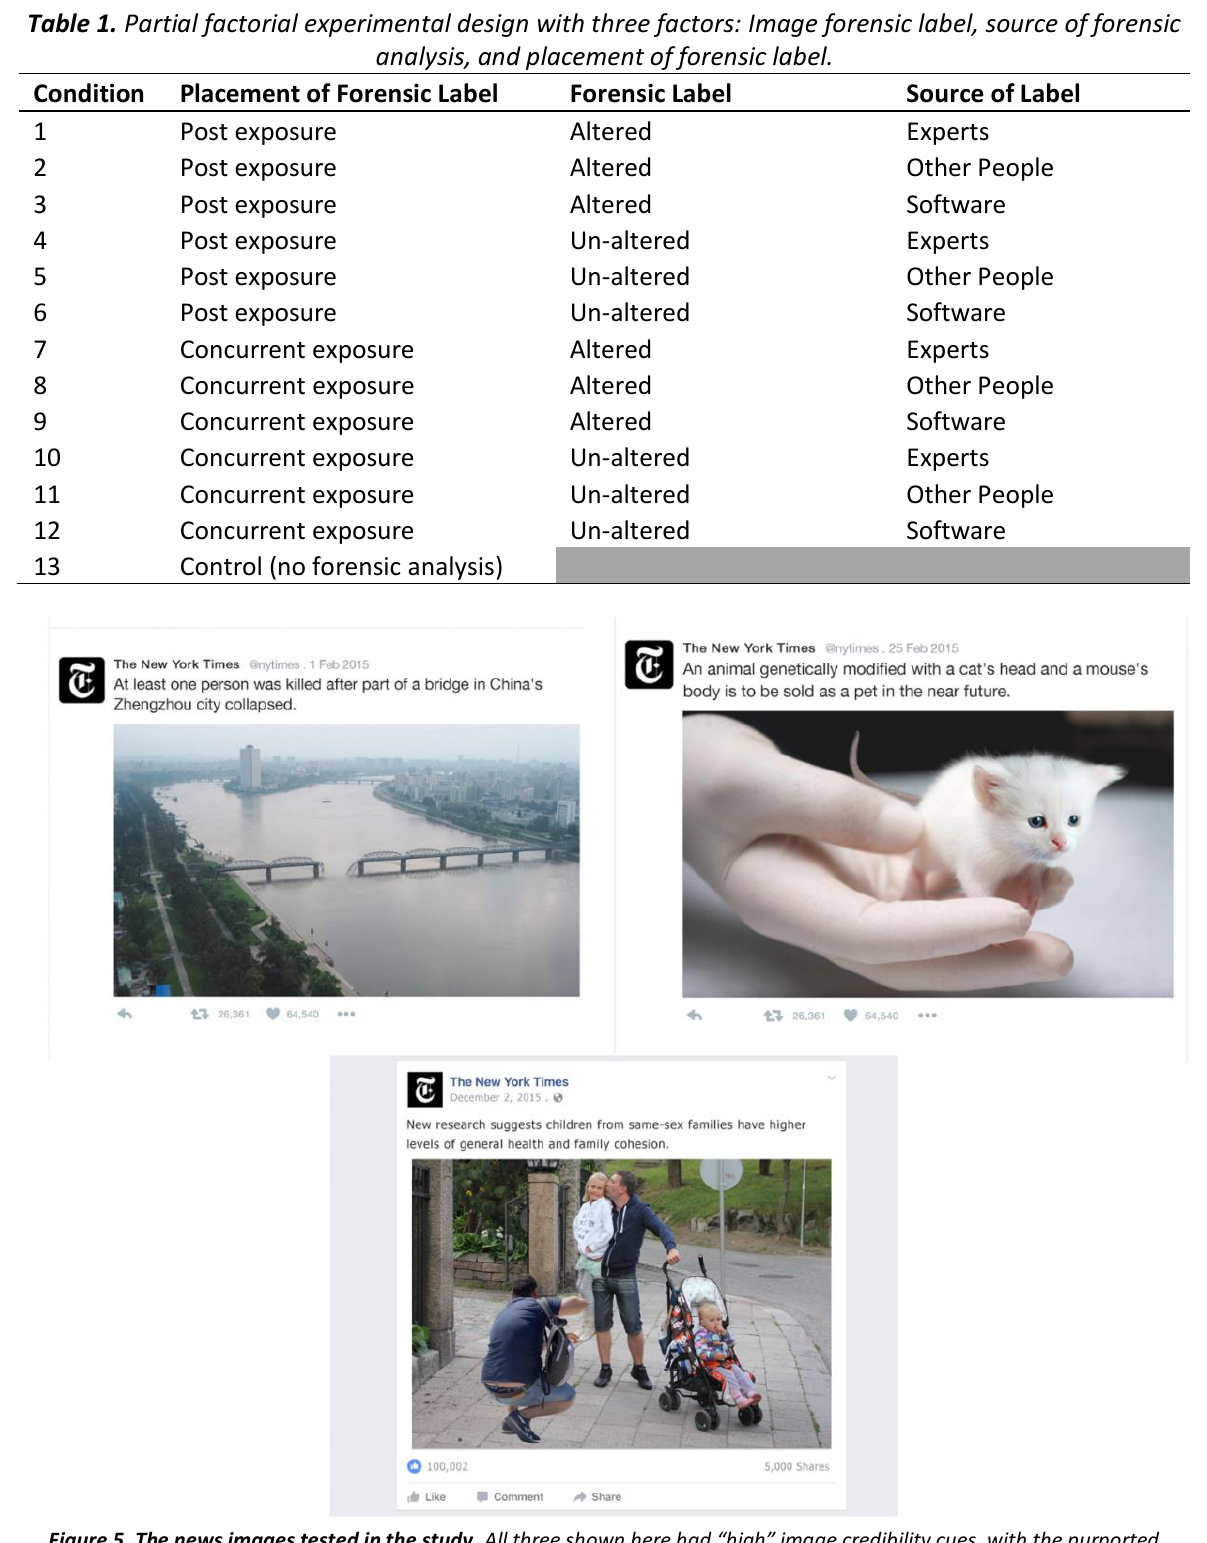
Figure 5. The news images tested in the study. All three shown here had “high” image credibility cues, with the purported source being the New York Times and high virality metrics (see Appendix for image credibility cue